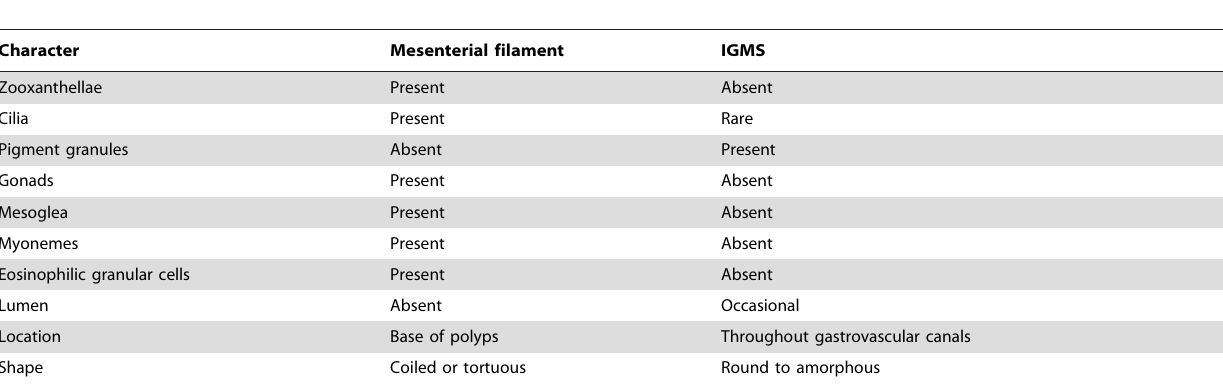
Table 1. Morphologic characteristics of mesenterial filaments versus invasive gastrovascular multicellular structures (IGMS) in M. capitata